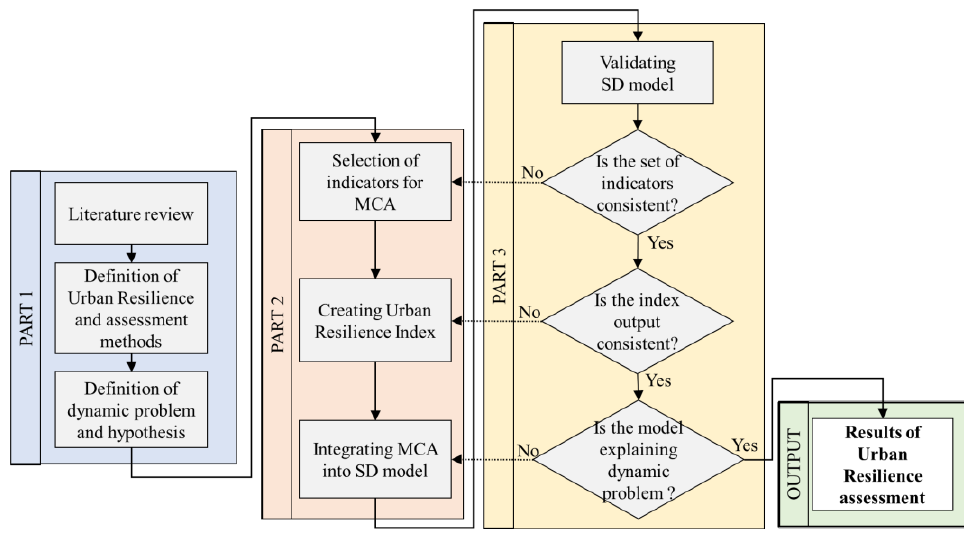
Fig. 1. Summary of methodology of the